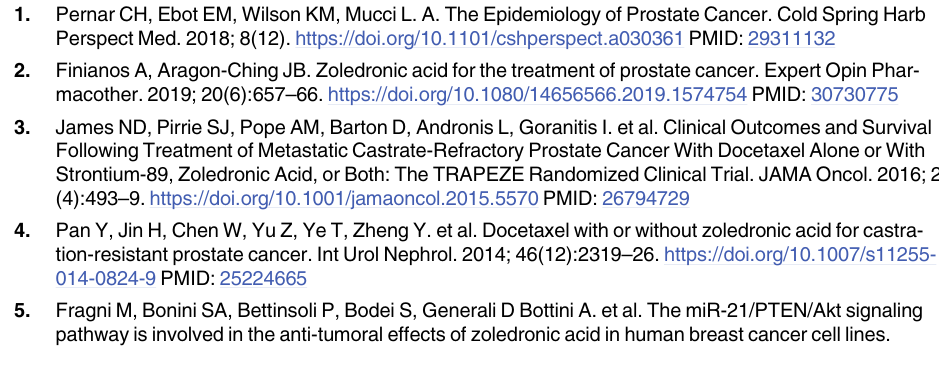
S1 Fig. Quality assessment of eligible studies. S2 Fig. Funnel plot of